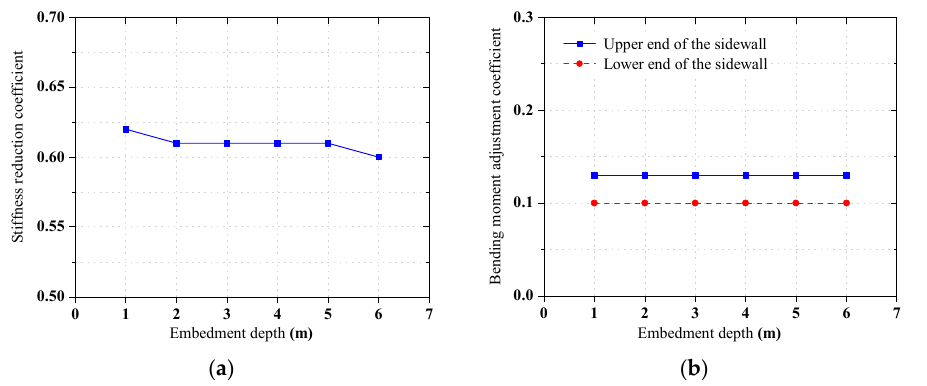
Figure 8. Influence of embedment depth: ( a ) stiffness reduction coefficient and ( b ) bending moment adjustment coefficient.